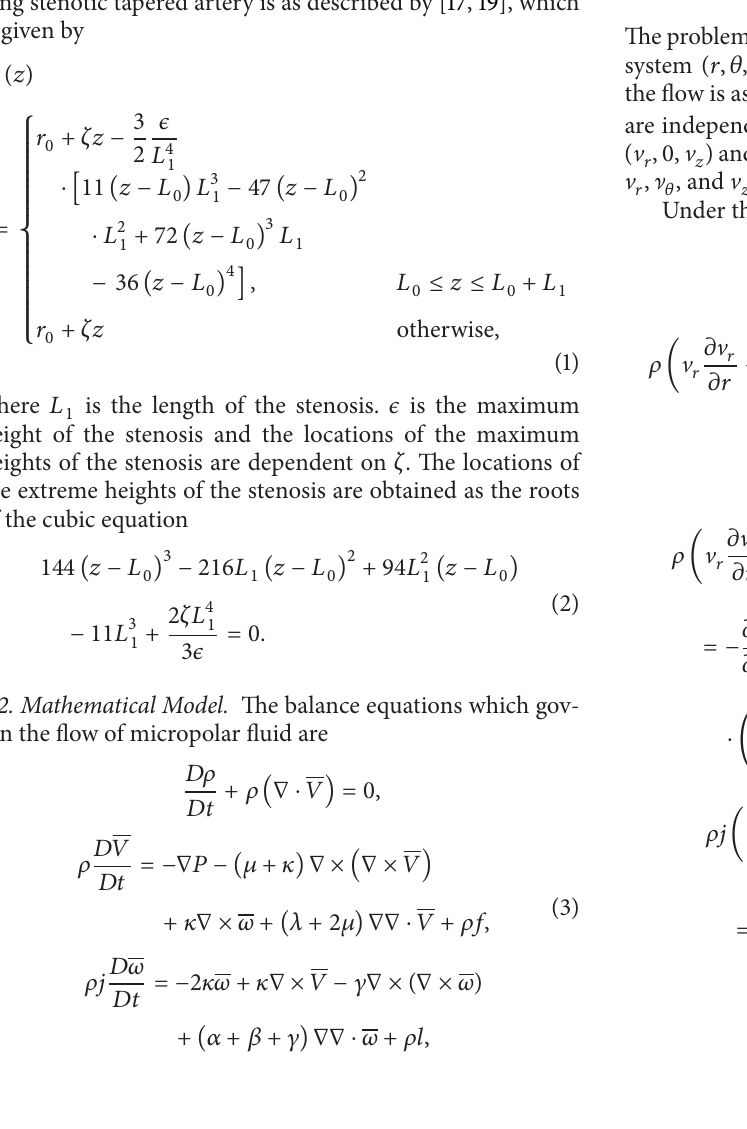
the stenosis is occurring. 𝑧 𝐶 indicates the location on 𝑧 - axis corresponding to the critical height of the overlapping